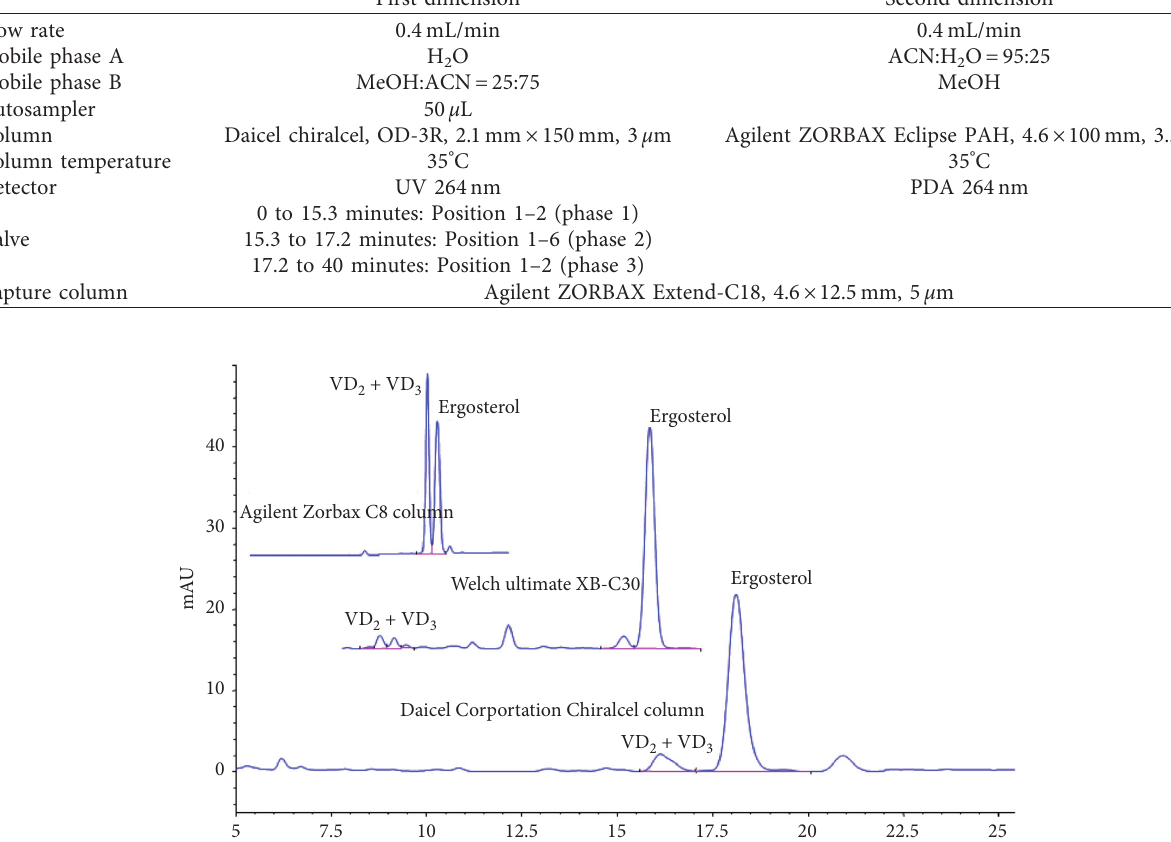
Table 1: The parameters of two-dimensional chromatography. First